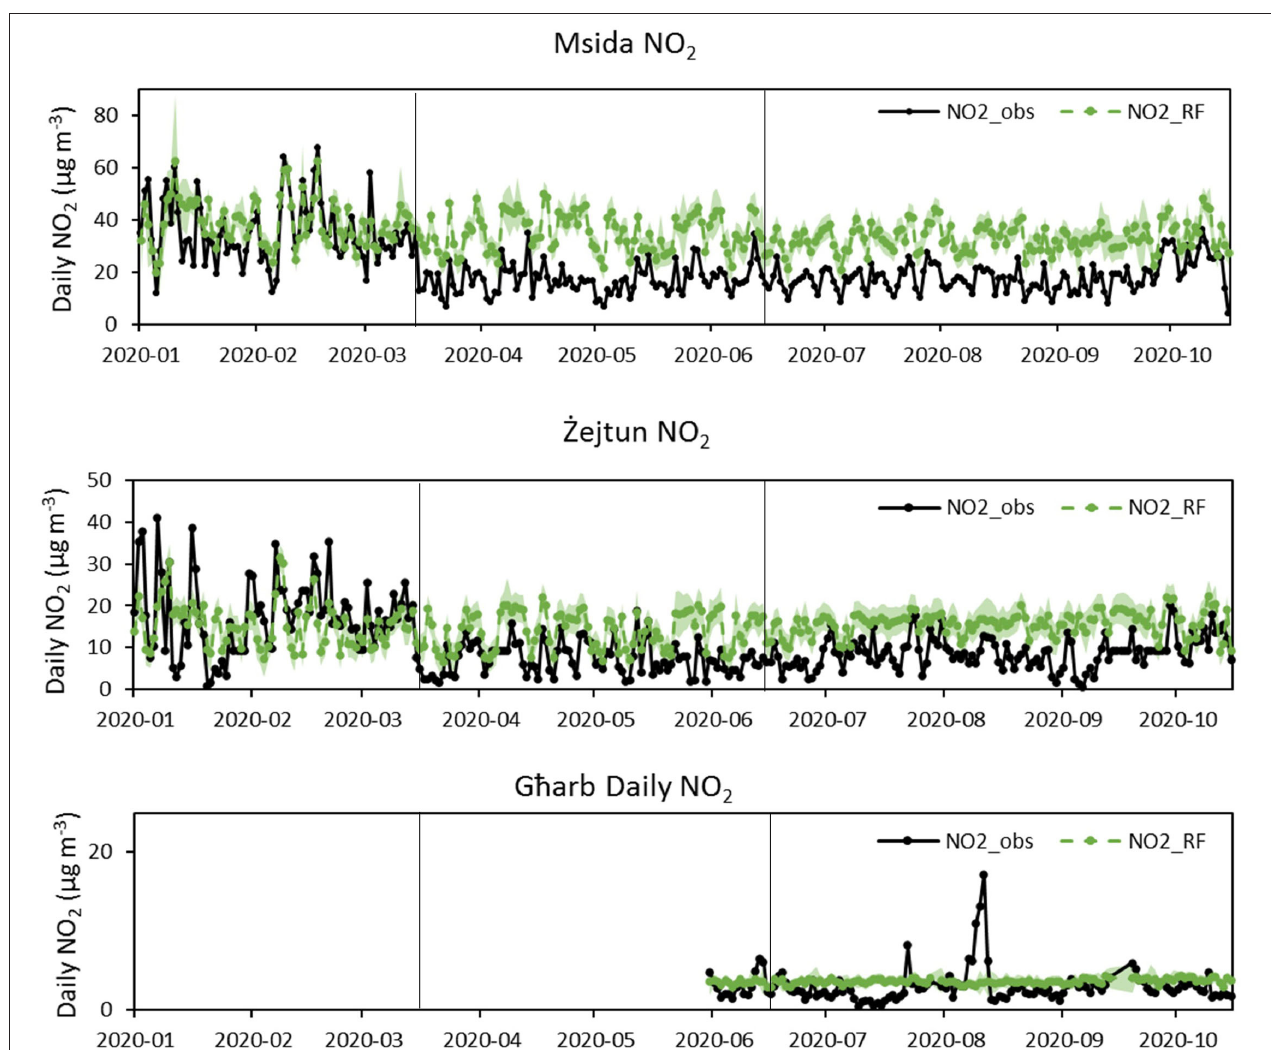
FIGURE 3 | Daily predicted (green) and measured (black) NO 2 concentrations at Msida, ˙Zejtun and G è arb between the 1st January and 15th October 2020. Shaded green area indicates the 95% confidence interval of the NO 2 predictions. N.B. the y -axis scale differs between the three panels. Vertical lines indicate the closure of schools on the 11th March and the end of the public health emergency on the 15th June